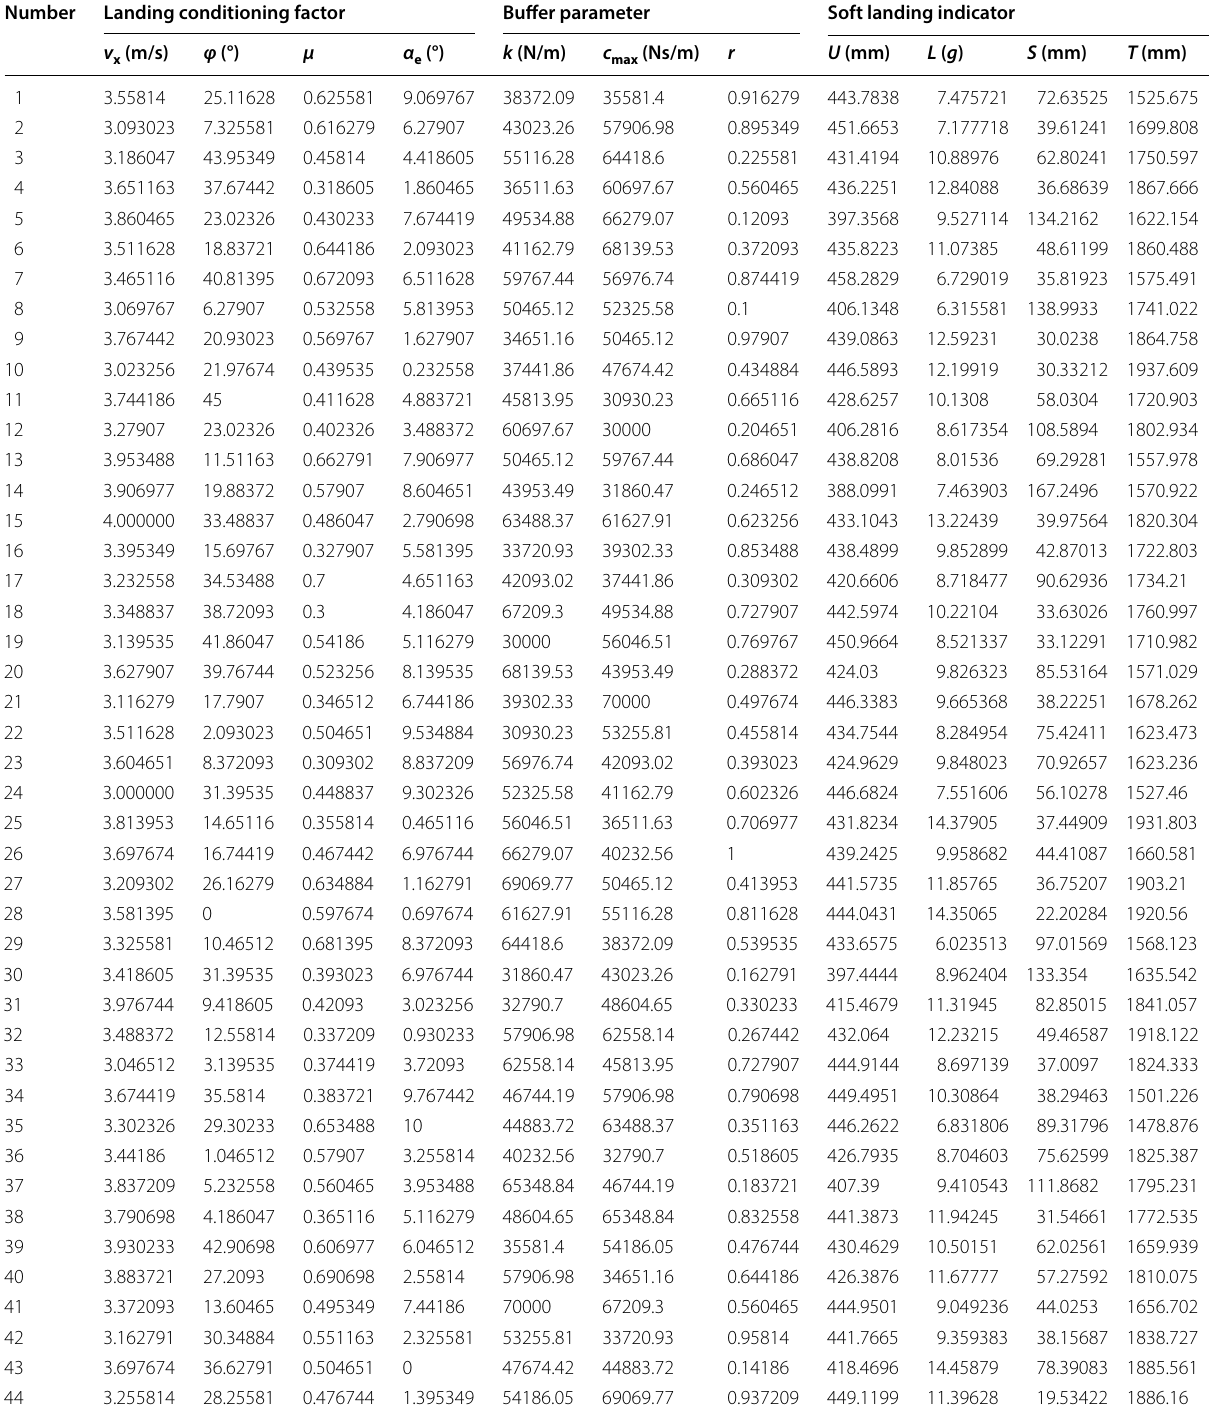
Table 11 Sample points for response